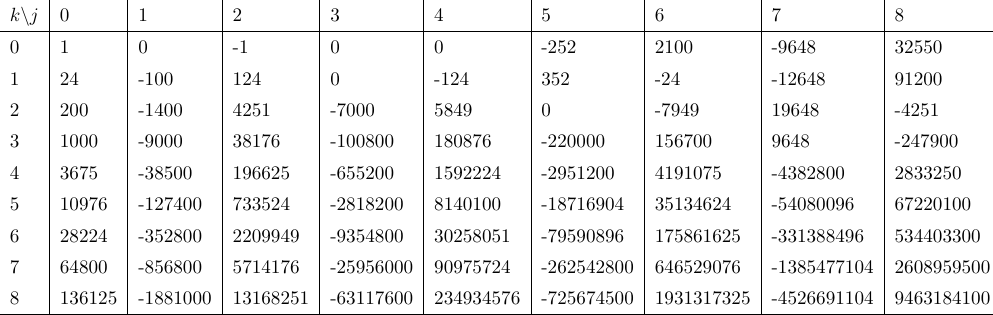
Table 50. Table of b jk coe(cid:14)cients for h SU(5)